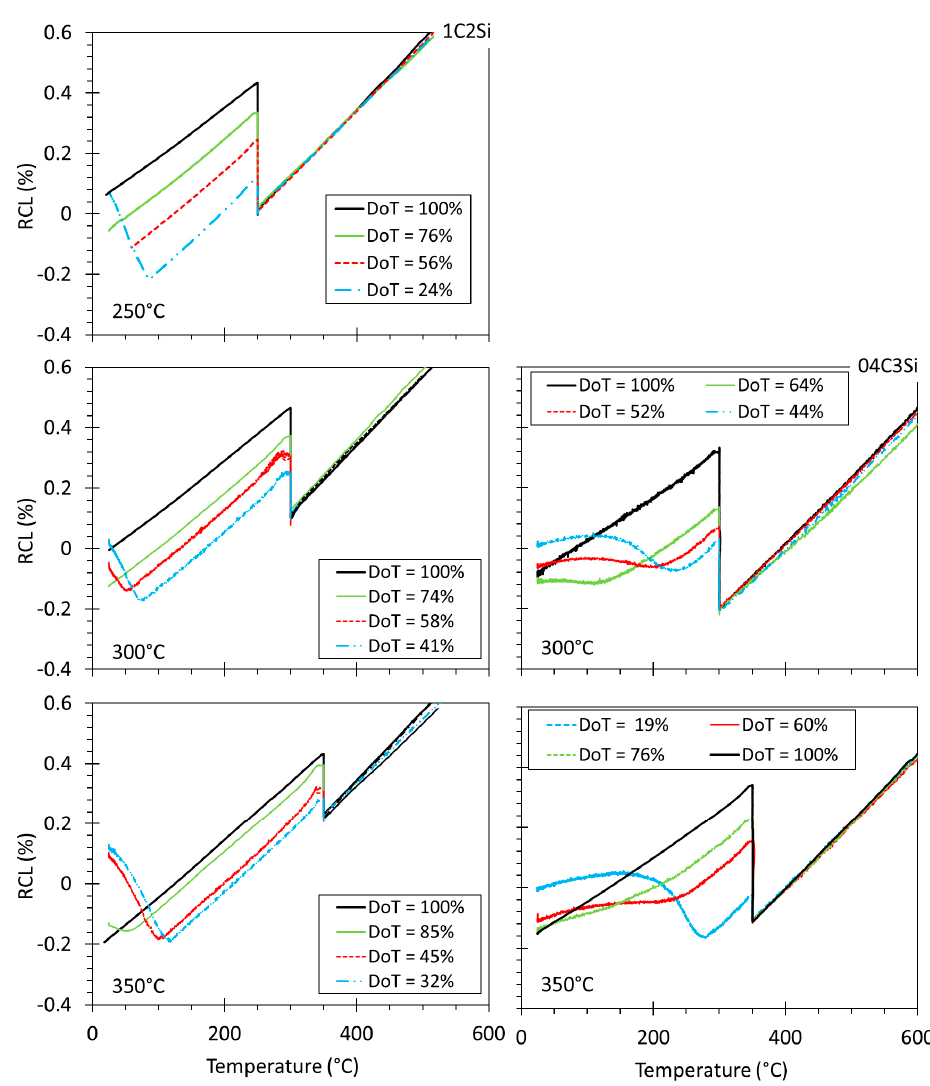
Figure 7. Relative change in length (RCL) of partially (P) and fully (F) transformed experiments; the degree of transformation (DoT) is also indicated.